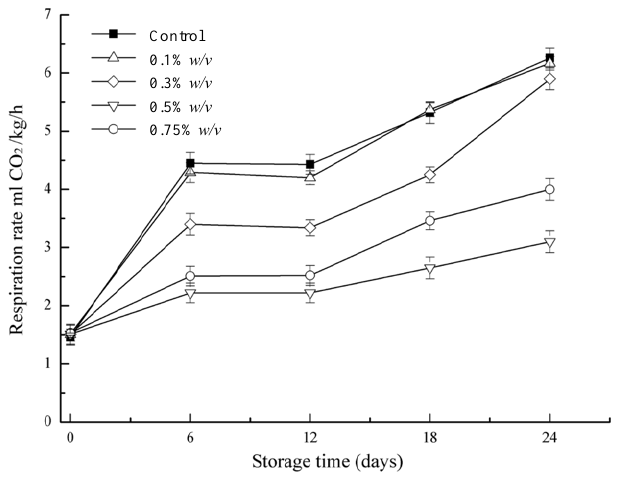
Figure 2. Change of respiration rate in sweet cherry stored at 10 °C during storage time. The data are the means ± standard-deviation (SD).